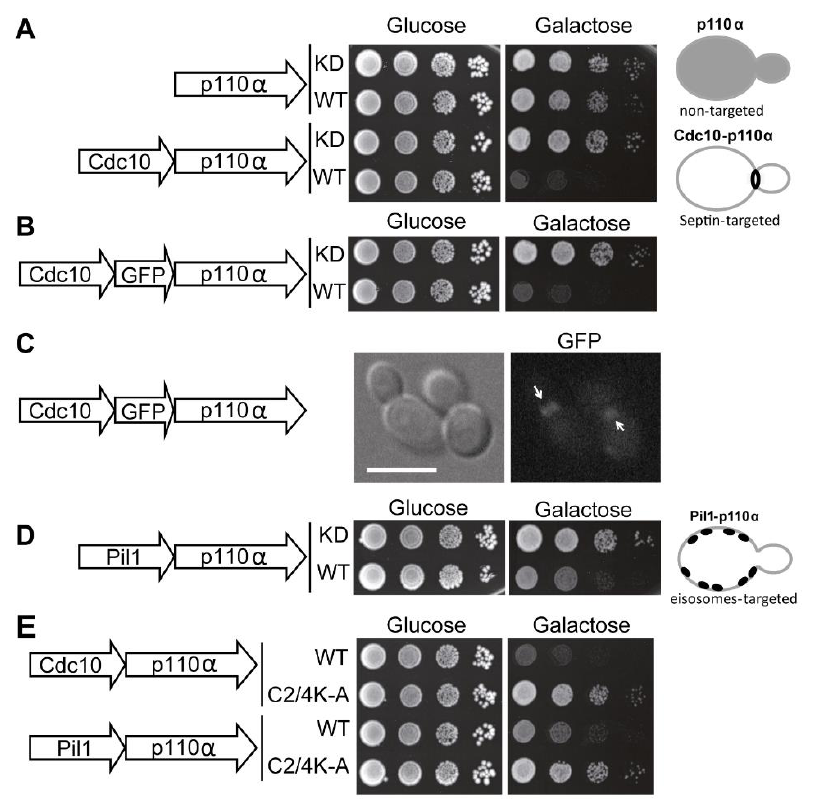
or YCpLG-Pil1-p110α C2/4K-A, as